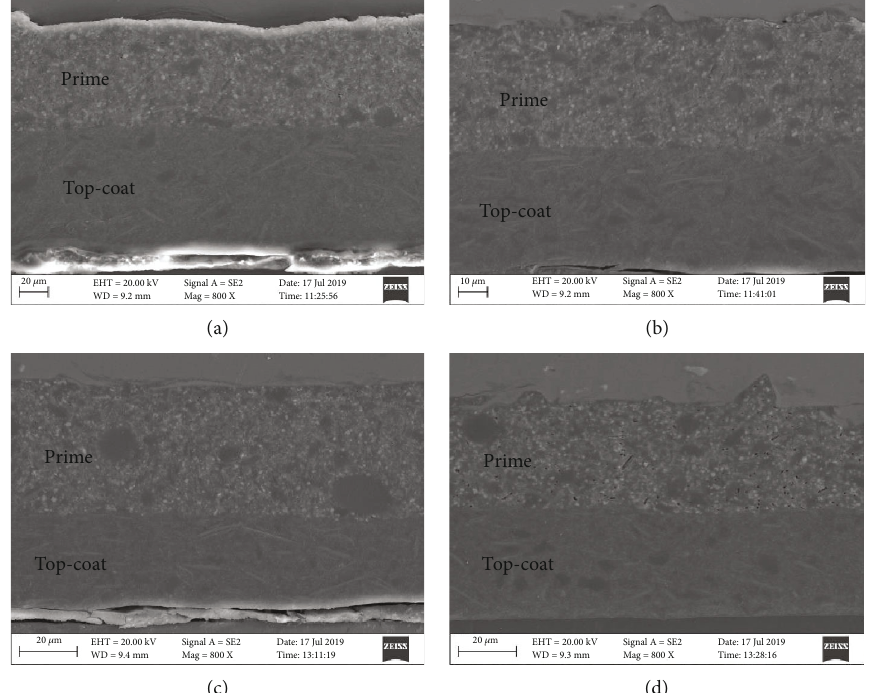
Figure 2: SEM of graphite-modi fi ed anticorrosive coatings with di ff erent percentages of rGO dispersed by F431 (a – d); the additional rGO are 0.2%, 0.4%, 0.6%, and 0.8%. Table 2: Porosity of original and graphene-modi fi ed coatings. Coatings